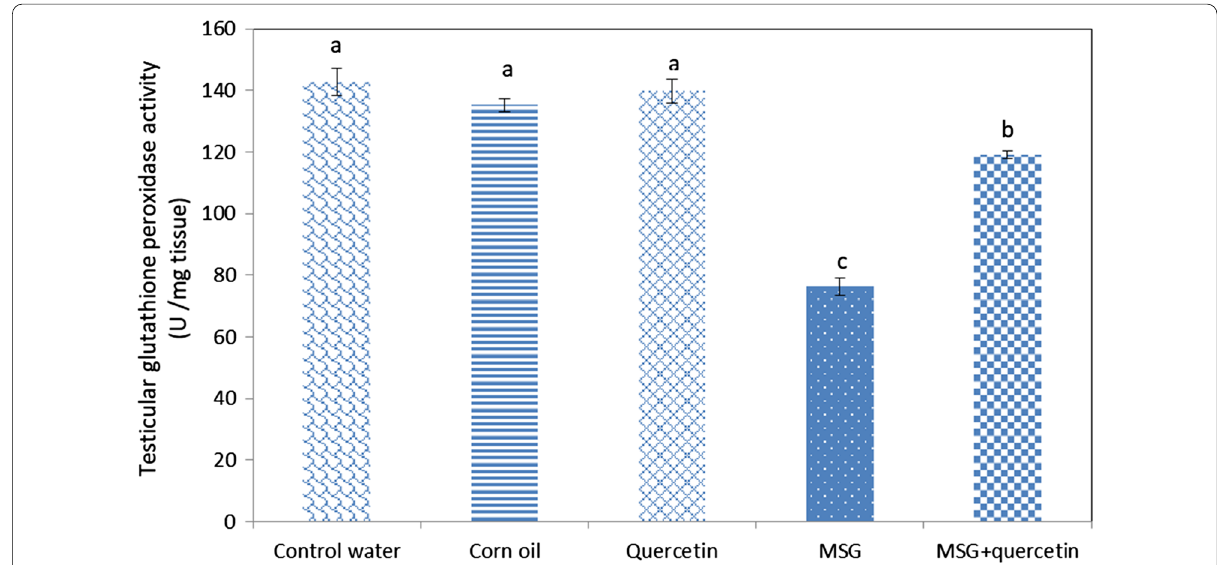
Fig. 3 Effect of quercetin on the level of glutathione peroxidase (unit per milligram tissue) in testis homogenate of MSG‑intoxicated male rats for 30 days. The number of Values were expressed as mean standard error. Means which share different superscript symbol(s) are significantly ± different at P < 0.001